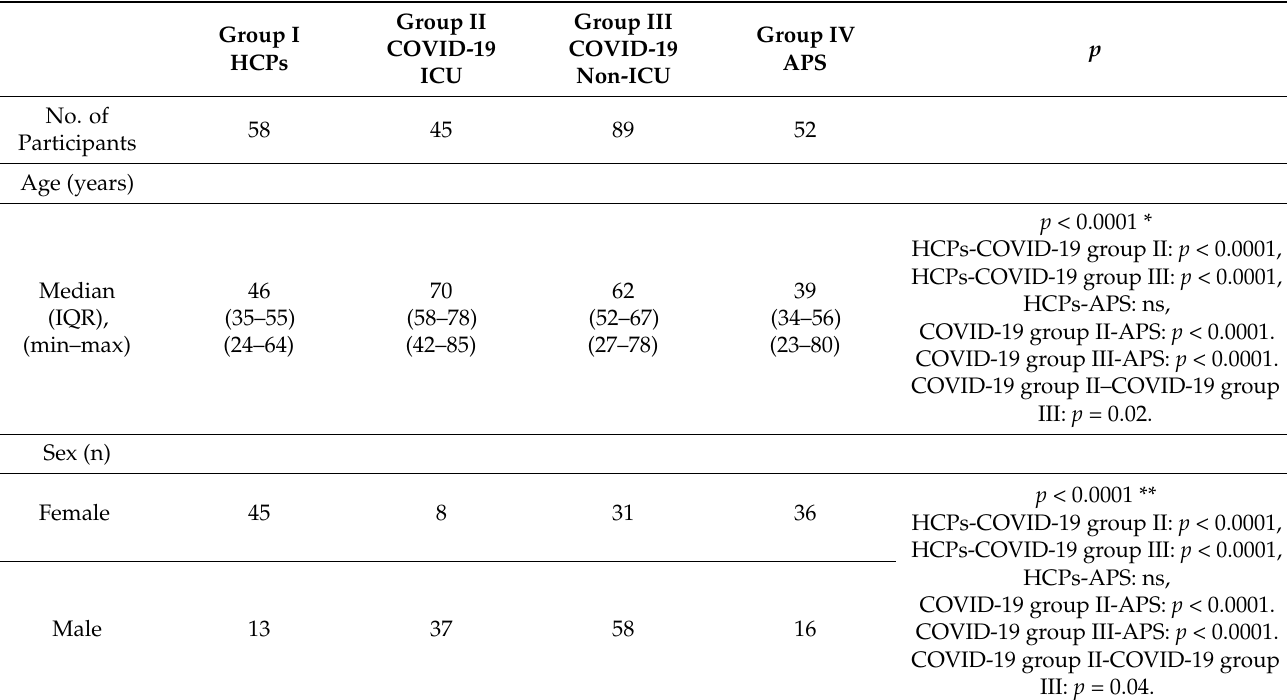
Table 1. Number of participants, sex and age distributions in the